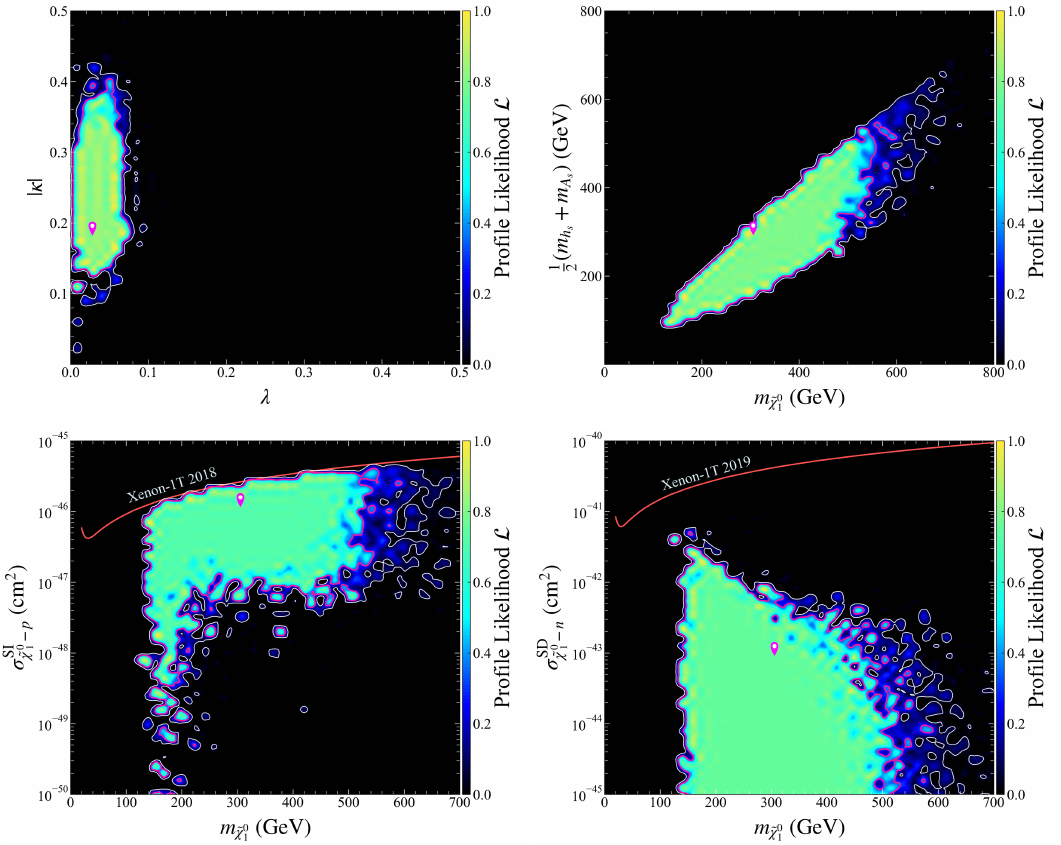
( m + m ) , m , and m − 1 − σ SD h s A s ˜ χ 0 1 ˜ χ 0 1 n 2